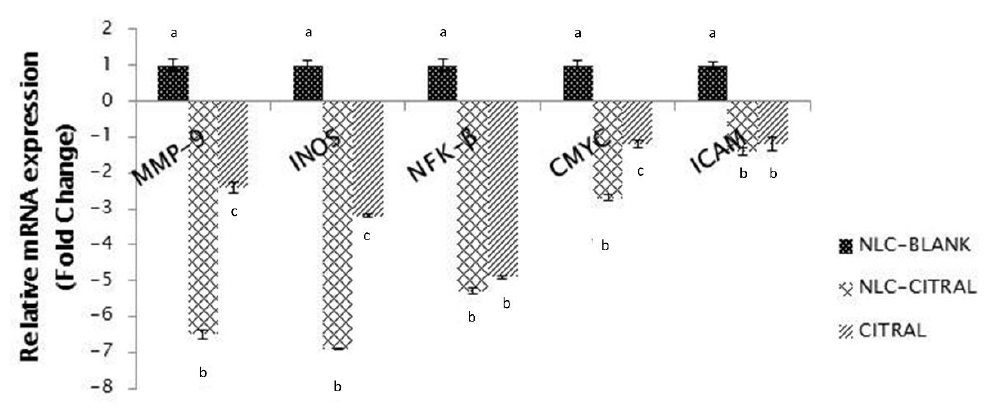
Figure 9. The relative mRNA expression level of MMP-9, iNOS, NFK- β, C -MYC, and ICAM. Each value is represented as mean ± SD and the experiment was performed in triplicate. Significance indicated by different alphabet was set at p < 0.05 comparing between groups.